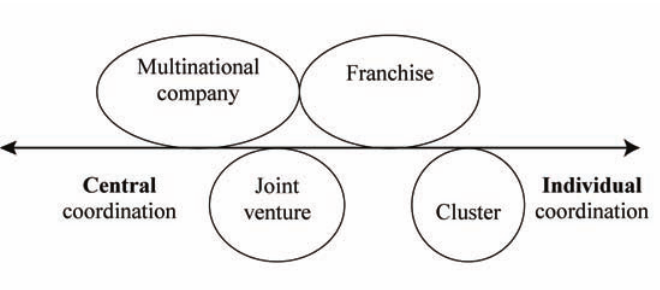
Fig. 4. The level of profit flow coordination in the different business collaboration structures A lower level of centralization takes place in joint ventures where operations are per - formed by at least two partners, it particular cases also with equivalent